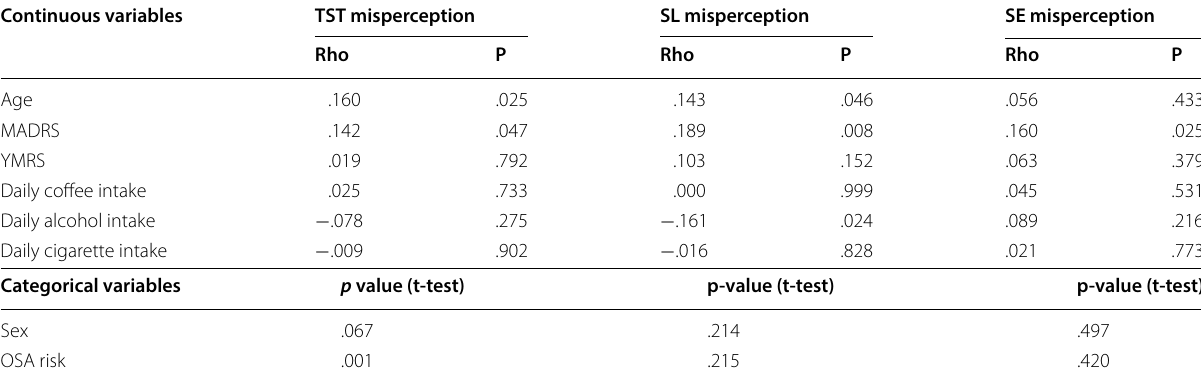
Table 2 Associations between misperception of sleep and demographic and clinical